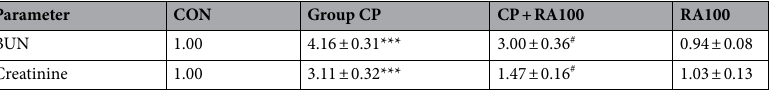
Table 1. Effect of RA on CP-induced changes in kidney function markers. All the data were calculated as fold values as compared with each group. CP-treated animals showed significantly (*** p < 0.001) higher levels of BUN and serum Cr when compared with control group of animals. However, treatment with RA at the dose of 100 mg/kg significantly ( # p < 0.05) reduces the level of BUN and Cr in CP + RA100 group of animals when compared with CP group of animals. No significant changes in the level of BUN and serum Cr were observed in RA100 treated group of animals vs. controls ( n =